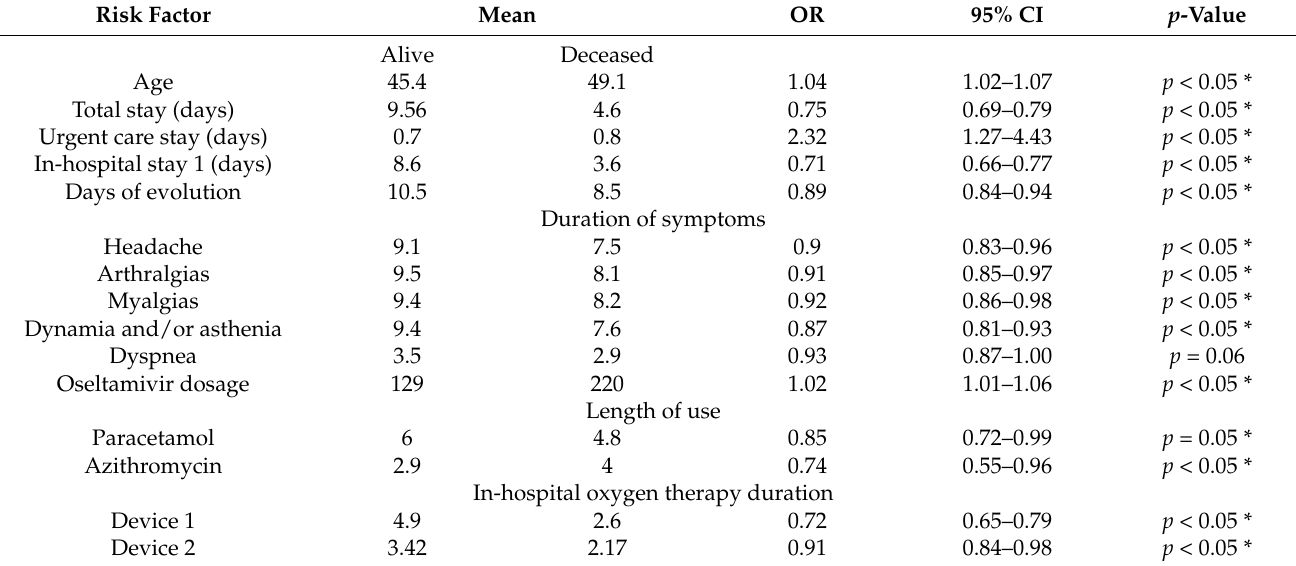
Table 2. Associations between mortality/survival due to COVID-19 and age, total hospital stays, stays per service, days of progression, the duration of symptomatology, prehospital treatment dose and length, and the time of intrahospital oxygen